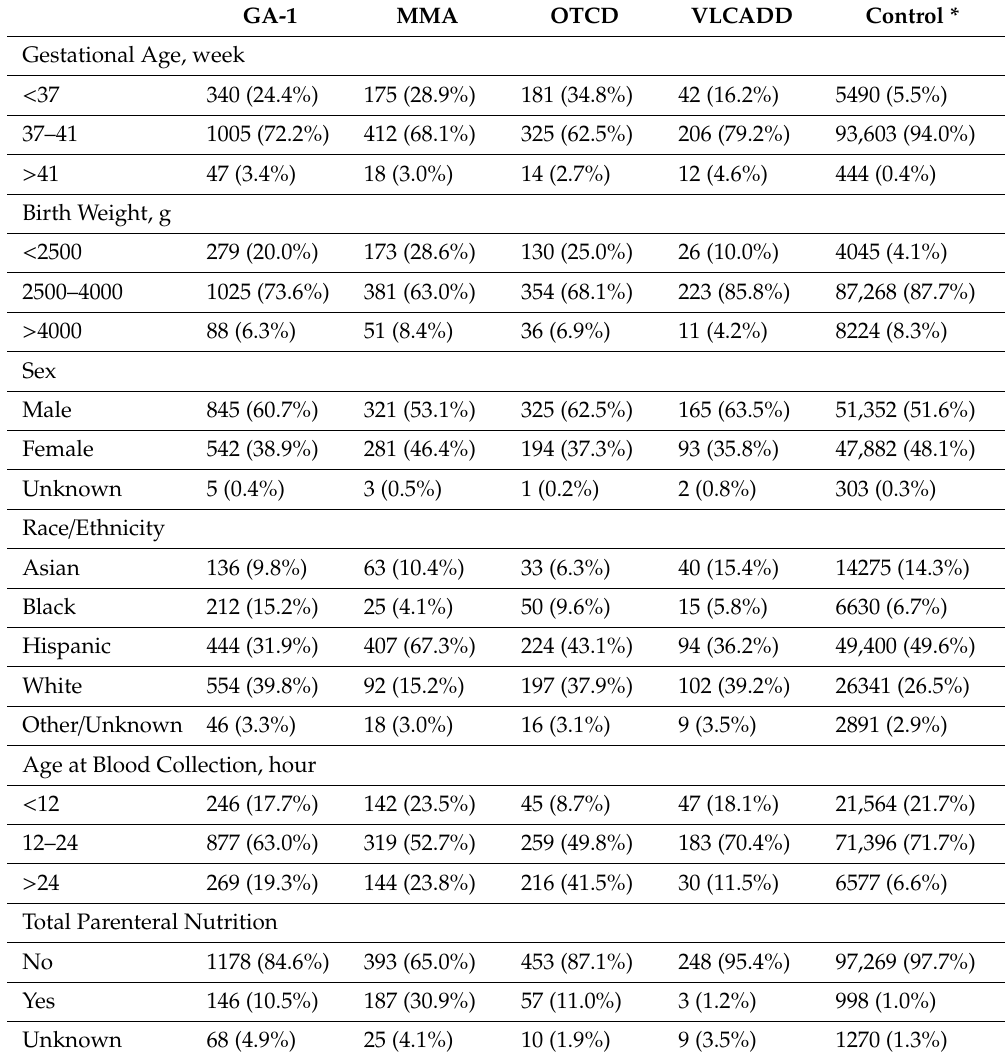
Table 2. Participant and Subgroup Demographics for four